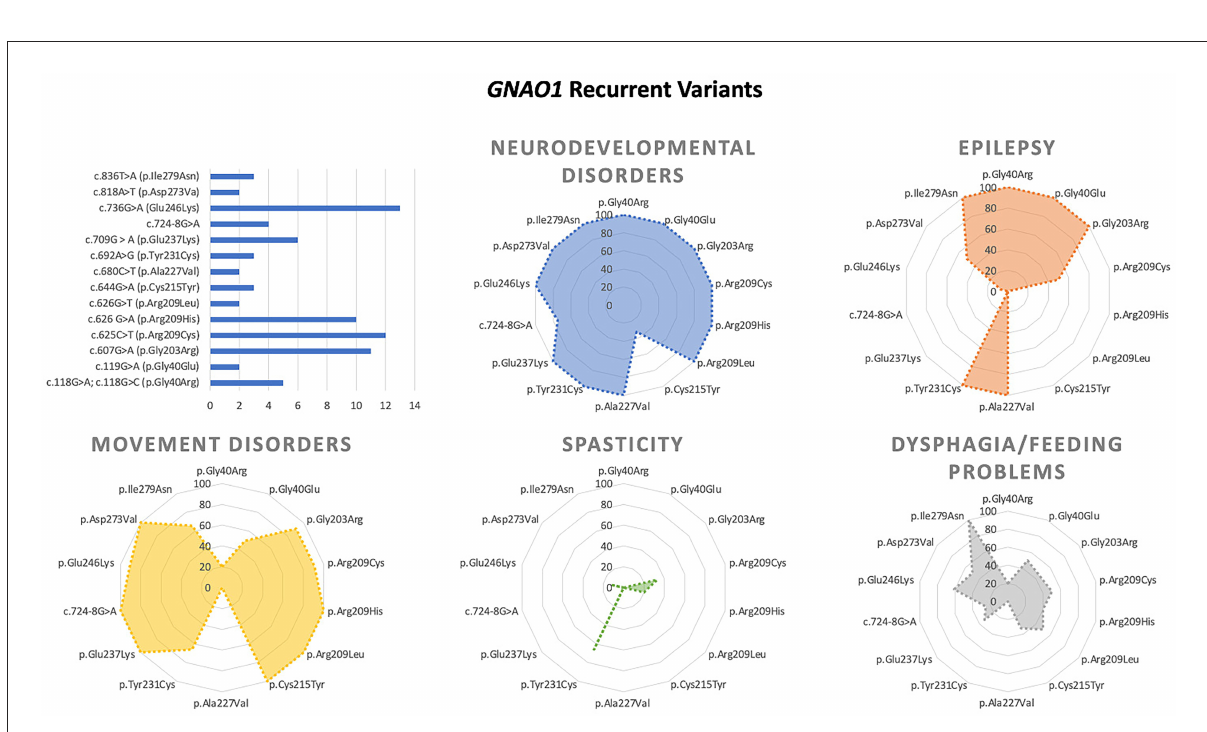
FIGURE4 Main genotype–phenotype correlations in GNAO1